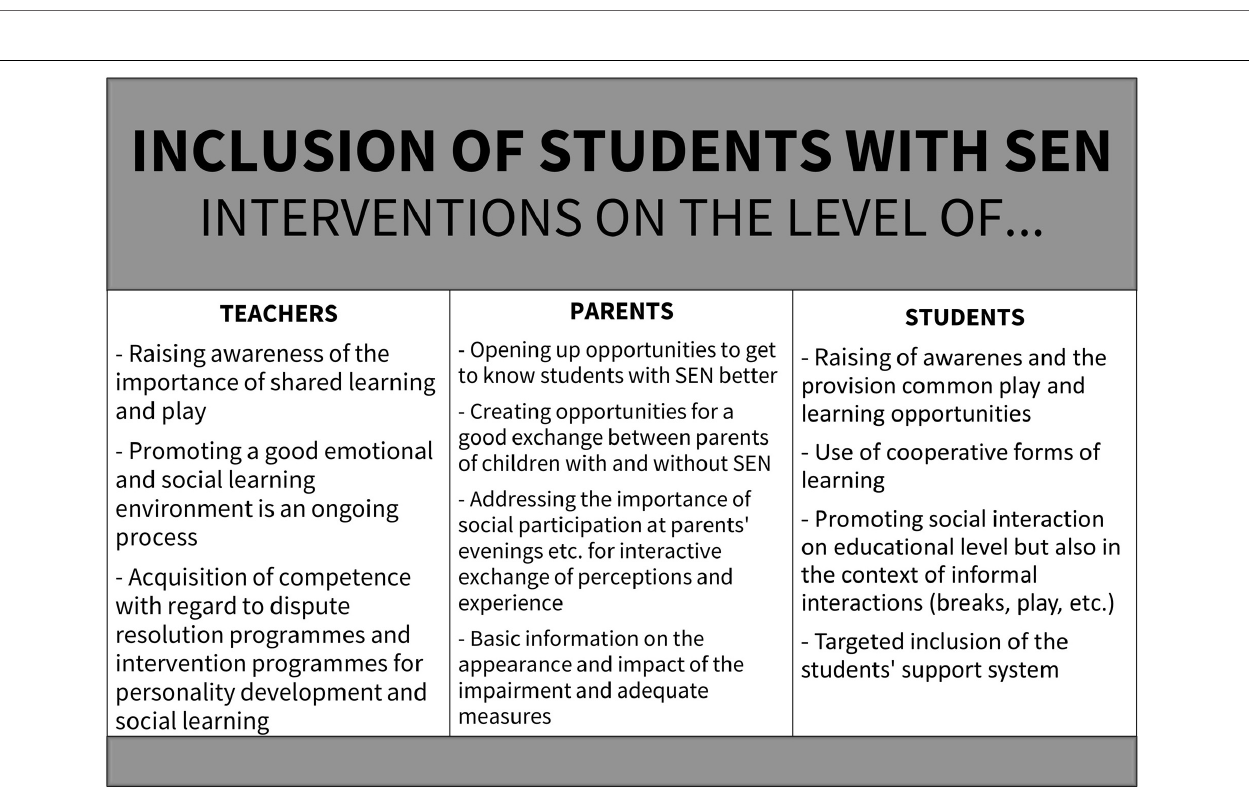
FIGURE 1 | Interventions for inclusive educational